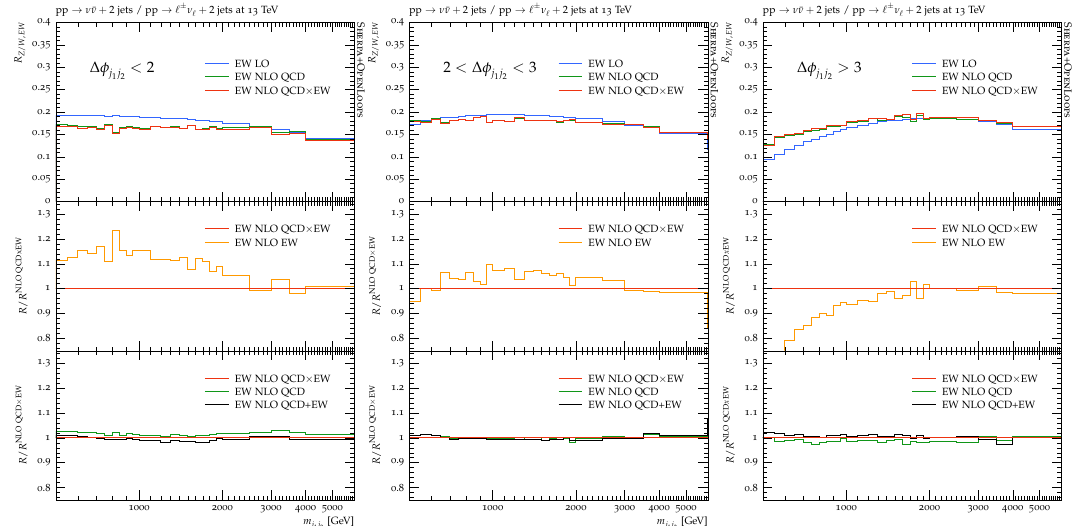
Figure 16. Ratios of the EW pp → Z ( ν ‘ ¯ ν ‘ ) + 2 jets and EW pp → W ± ( ‘ ± ν ‘ ) + 2 jets distributions in m j without jet veto in the regions ∆ φ j 1 j 2 (right). Same higher-order predictions and conventions as in figure 12, but without matching to the parton